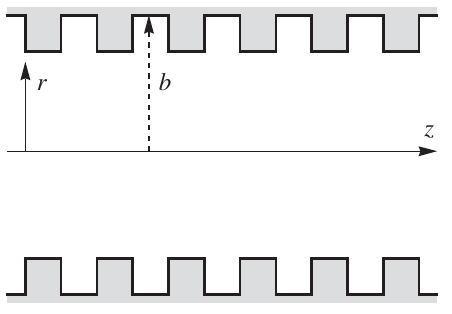
FIG. 1. A round pipe of radius b with rectangular corrugations in the